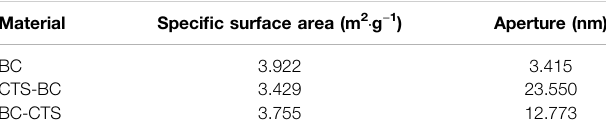
TABLE3| Speci fi csurfaceareaandporesizeanalysisdataofthethreeadsorbent materials.